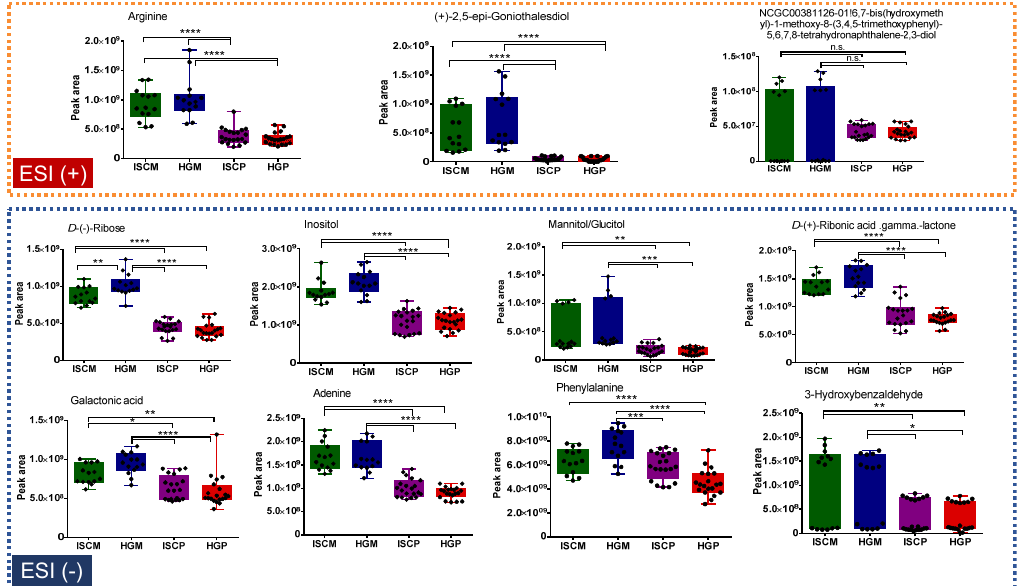
Figure 5. Box plot graphs of annotated metabolites responsible for the discrimination of M. domestica group from P. sylvestris in the PLS-DA model. Abbreviations: ISCM: M. domestica / APVAE, HGM: M. domestica / VAE, ISCP: P. sylvestris / APVAE; HGM: P. sylvestris / VAE. Tukey’s multiple comparison test was performed for significant difference. * p < 0.05; ** p < 0.01; *** p < 0.001; **** p < 0.0001. n .s. (not significant): p >